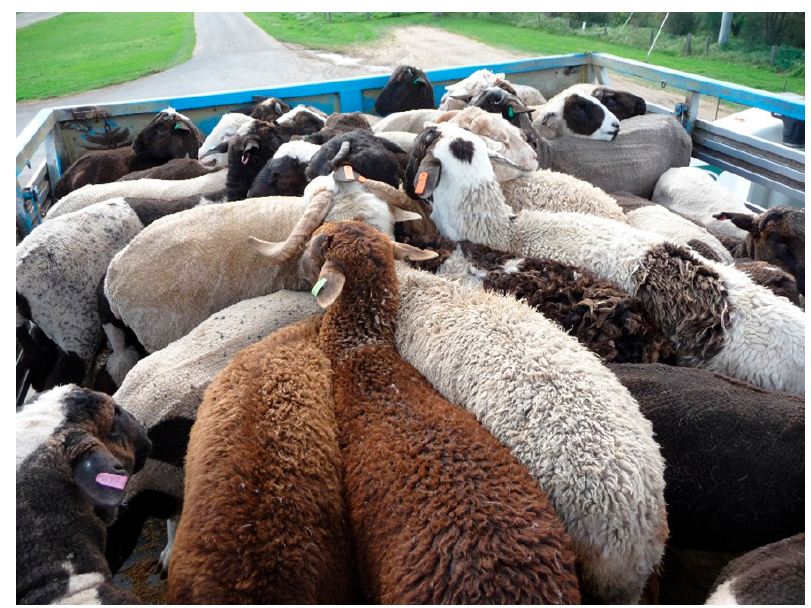
Figure 4. View of a typical consignment of fat-tail sheep in a convertible crate.